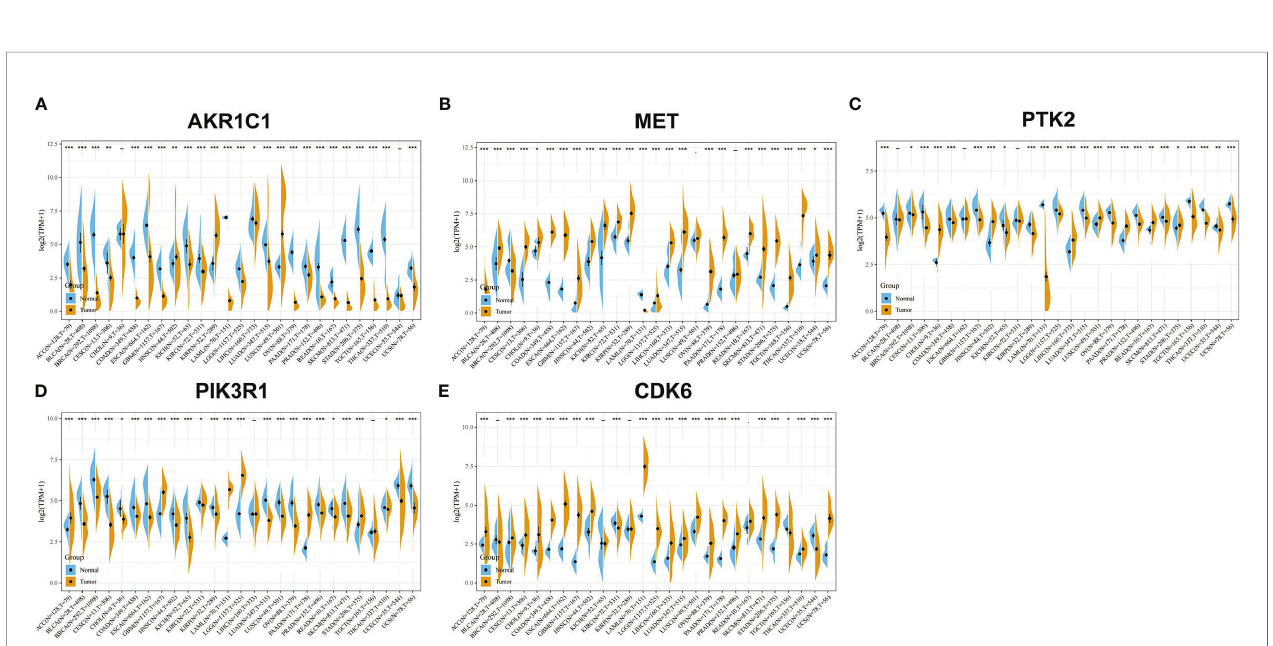
FIGURE 3 | Gene expression analysis of potential target proteinsof T. hemsleyanum in pan-cancer. (A) AKR1C1. (B) MET. (C) PTK2. (D) PIK3R1. (E) CDK6. *p< 0.05, **p < 0.01, ***p < 0.001.